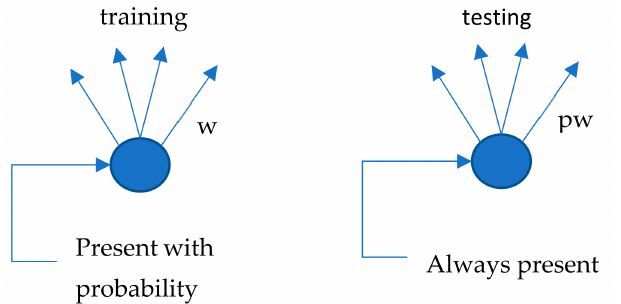
Figure 9. Dropout technology, where p—given probability value, w—neural network sites